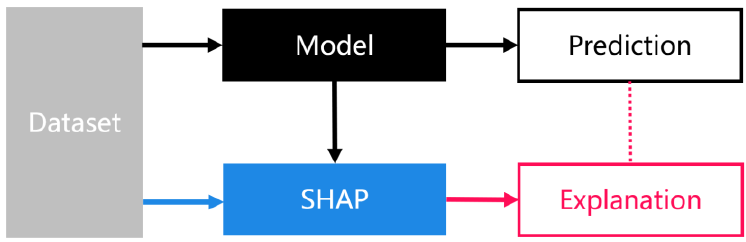
Figure 3. Interpretability framework based on SHAP values.